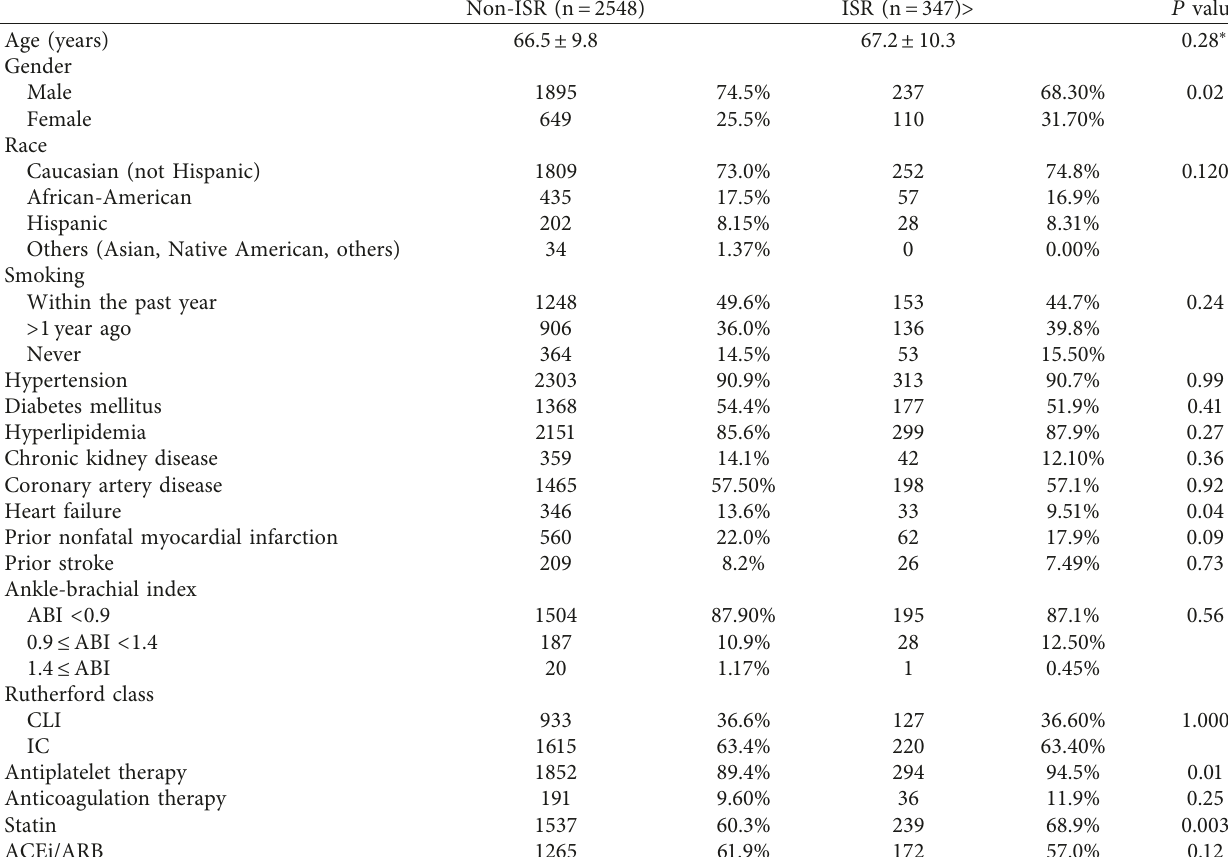
Table 1: Baseline characteristics for femoropopliteal (FP) non-in-stent restenosis and in-stent restenosis (ISR)